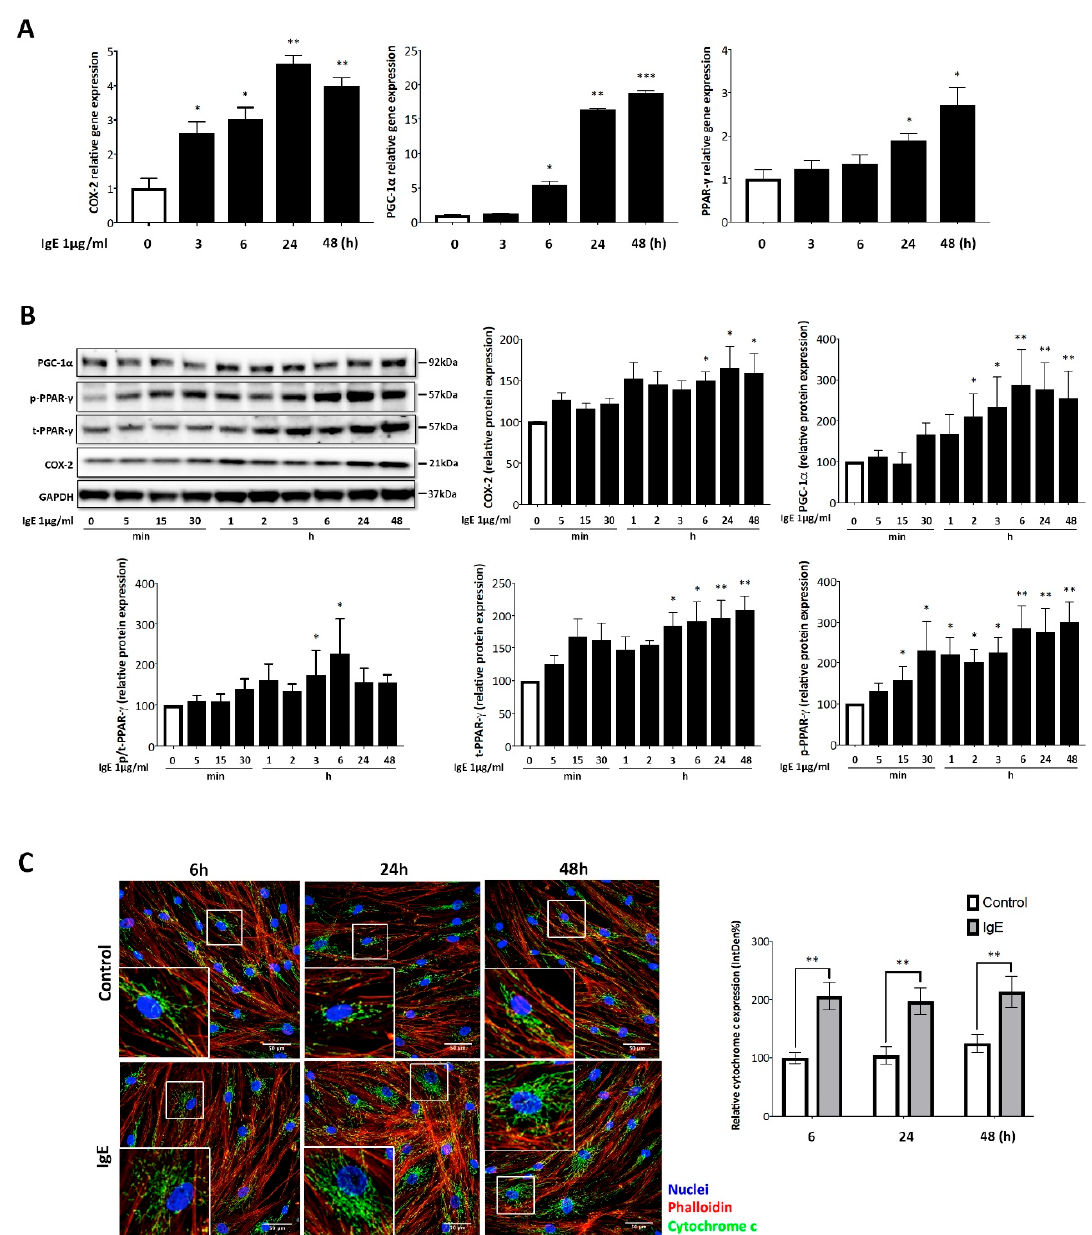
Figure 3. IgE stimulated mitochondria function-regulating genes and proteins. ( A ) IgE-induced gene expression of COX-2, PGC-1 α , and PPAR- γ assessed by real-time PCR in ASMC of asthma patients ( n = 5). Data are expressed as the percentage of none-treated cells at the same time point and bars represent mean ± SEM at the respective time points. * p < 0.05, ** p < 0.01, *** p < 0.001. ( B ) Western blot analysis for PGC-1 α , COX-2, total- and phosphorylated-PPAR- γ in asthma patient’s ASMC ( n = 5). Quantitation of the protein bands was performed with the Image J software. Bars represent mean ± SEM as the percentage of control at the respective time points. * p < 0.05, ** p < 0.01. ( C ) Representative confocal microscopy images for cytochrome c (green), F-actin (TRIC-Phalloidin, red), and nuclei (DAPI, blue) (600X magnification in enlarged boxes). Quantitation of fluorescence for cytochrome c was performed by Image J software as integrated density percentage of 10 single cells of asthma ASMC ( n = 5). Bars represent mean ± SEM results obtained from 50 cells. ** p < 0.01, ASMC in the absence of IgE at 6 h were defined as 100%.